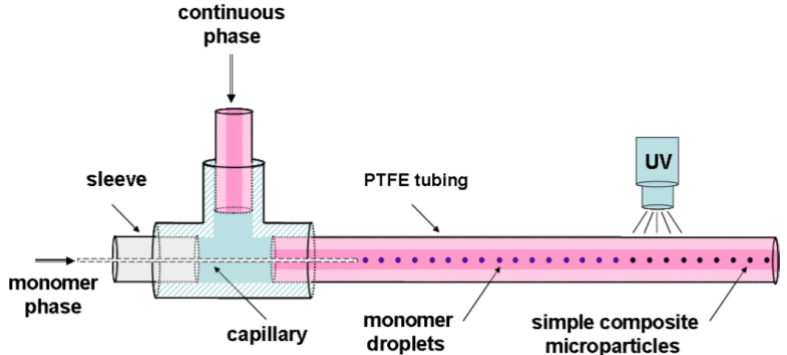
Figure 29. Schematic drawing of the capillary-based system for the production of simple composite [43].